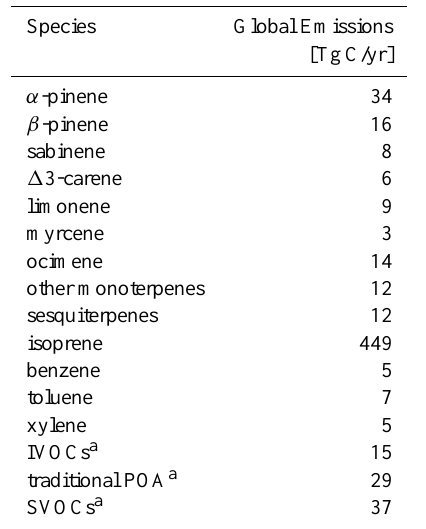
Table 2. SOA precursor emissions. Emissions are for year 2000 using GEOS-4 assimilated meteorology at 2 ◦ latitude by 2.5 ◦ lon- gitude horizontal